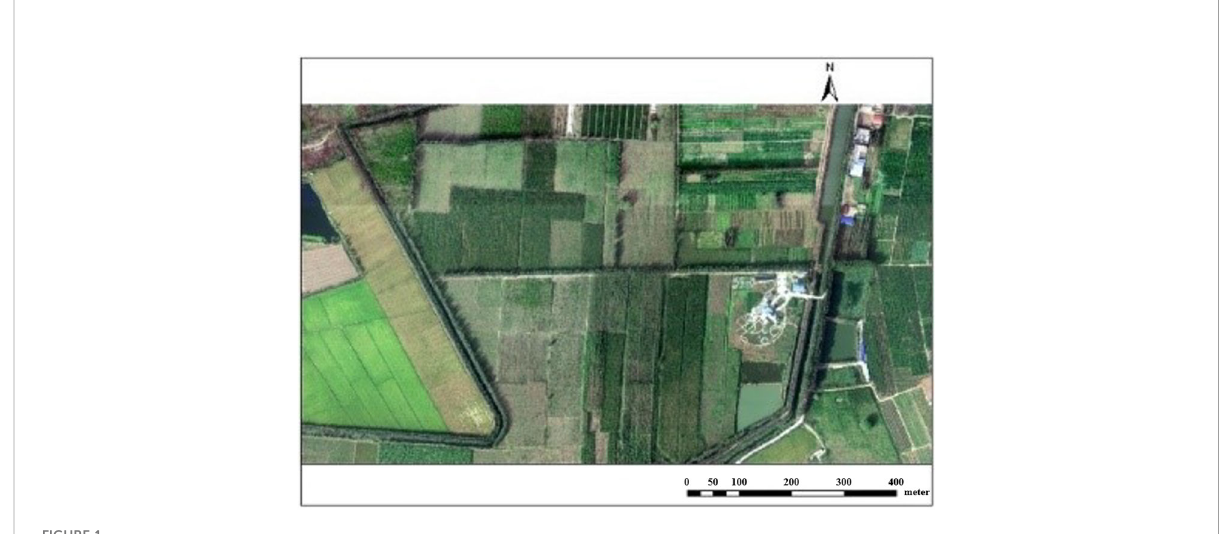
FIGURE 1 Hyperspectral image of MaTiWan